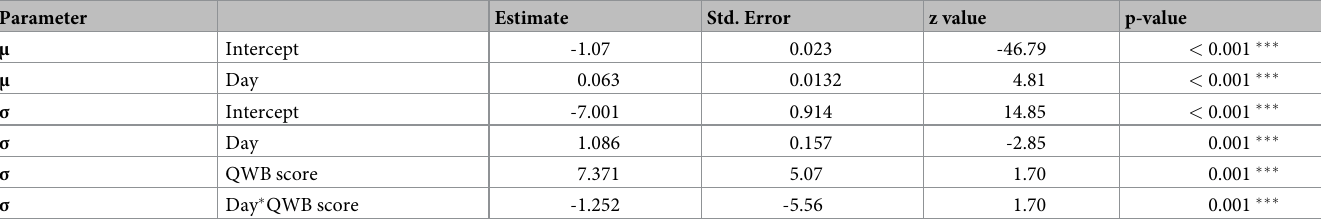
Odds ratios are for days 1–3, 4–6, and 7–9 after symptom onset, as compared to the post-illness time period, based on logistic GLMMs. For houses, the odds ratios are given for family member’s houses (vs. friend’s houses). Significant associations between time period and location visitation are denoted with asterisks ( � p < 0.05, �� p < 0.01, ��� p < 0.001).